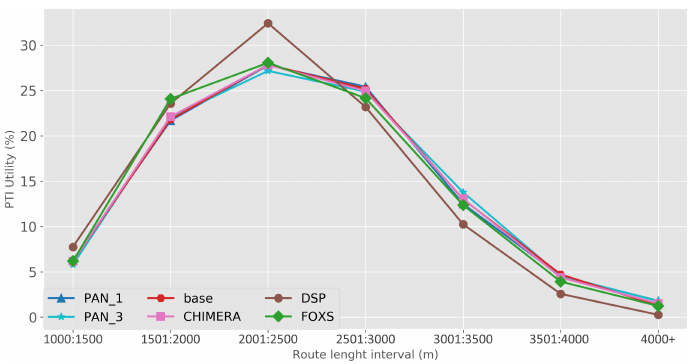
( a ) Route size Histogram. Figure 12. Route Size Analise—Ottawa Scenario.